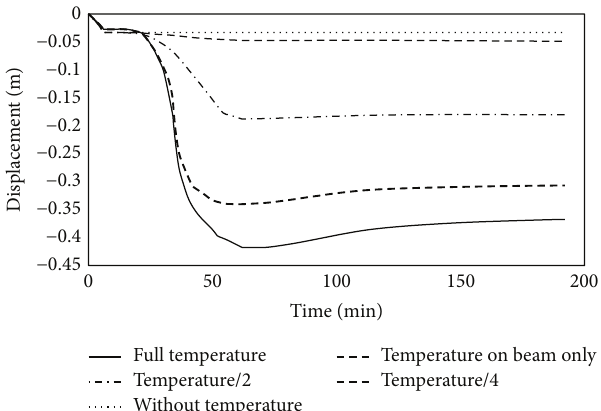
Figure 13: Shift diagram in the middle of the beam for connection to the end plate.